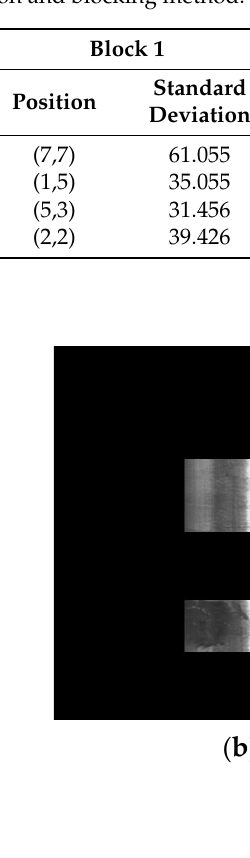
Figure 7. Flow chart of adaptive partition and block operation for the image of interest (IOI).